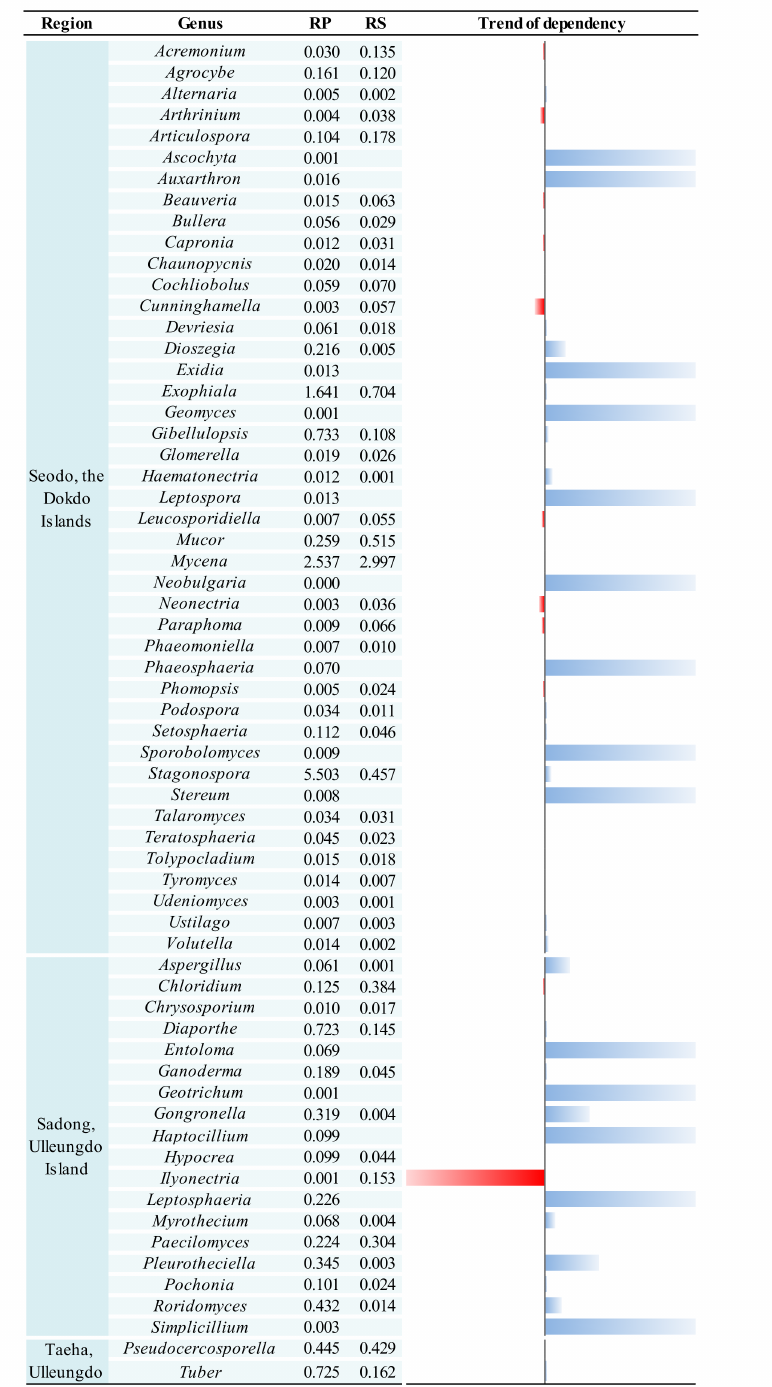
Figure 6. Unique fungal genera distributed in the RP and RS in each geographically isolated region and their host dependency. Blue bars indicate host dependency and red bars indicate increased dominance ratio as physical distance is away from the RP towards to the RS. Each number indicates the relative percentage of each genus and the trend of dependency of each genus was calculated by the following equation: (RS −